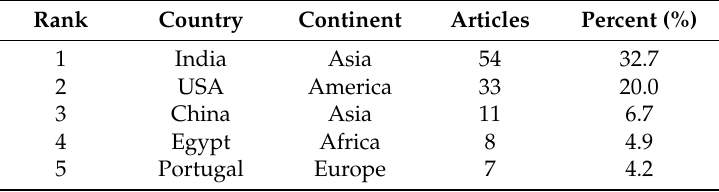
Table 1. The 5 most productive countries for publications of effects of xenobiotics on glucose metabolism in testes.